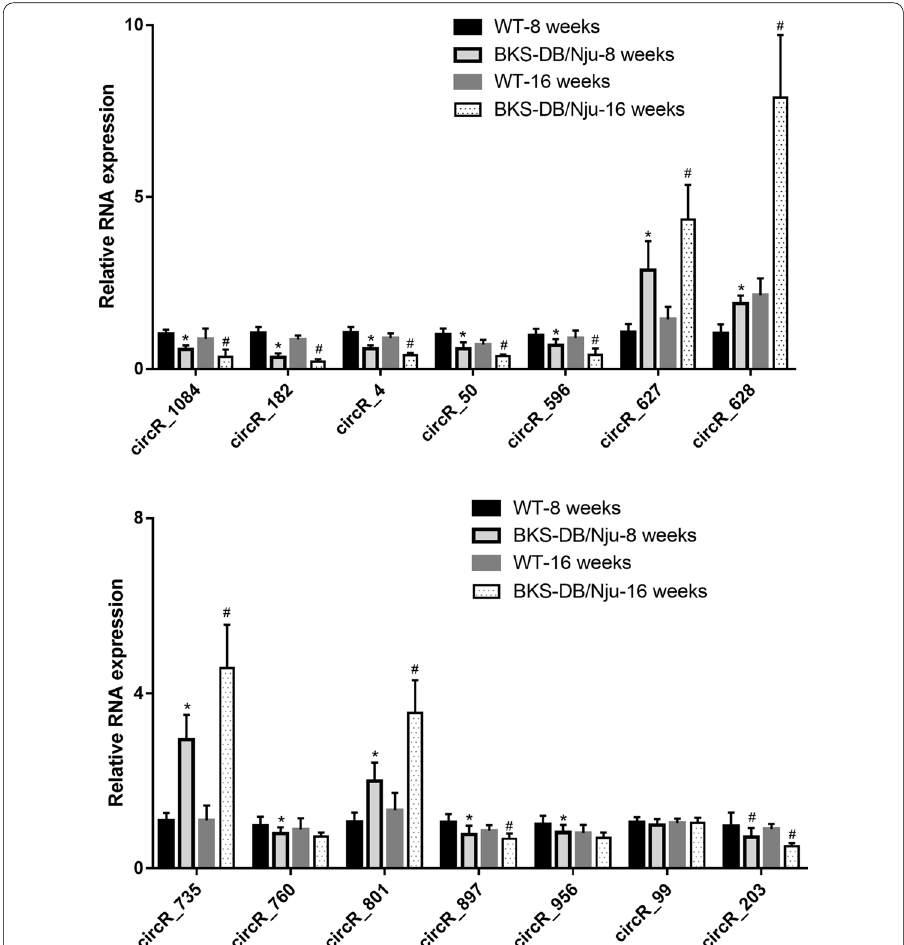
Fig. 4 Expression levels of 14 circular RNAs (circRNAs) in the renal tissues obtained from both diabetic nephropathy mice BKS-DB/Nju and wild-type (WT) mice (8 weeks old and 16 weeks old). * P < 0.05, BKS-DB/ Nju-8 weeks vs. WT-8 weeks; # P < 0.05, BKS-DB/Nju-16 weeks vs. WT-16 weeks; n